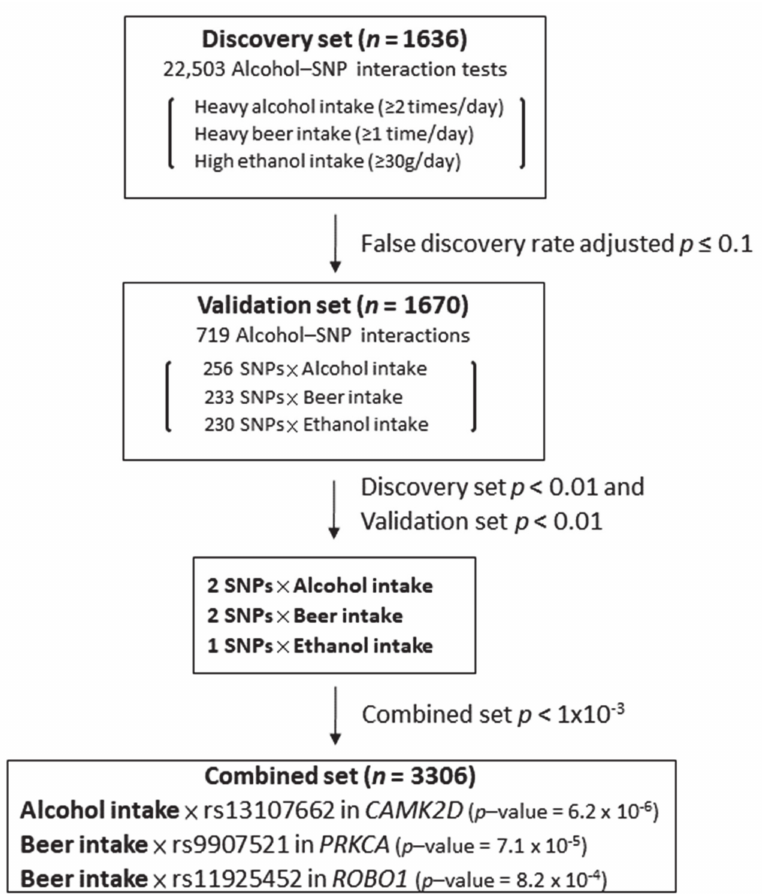
Figure 1. Process of identifying alcohol–single nucleotide polymorphism (SNP) interactions associ- ated with prostate cancer aggressiveness. Note: p -values were based on the logistic model adjusting for study site, the first six principal components, and smoking